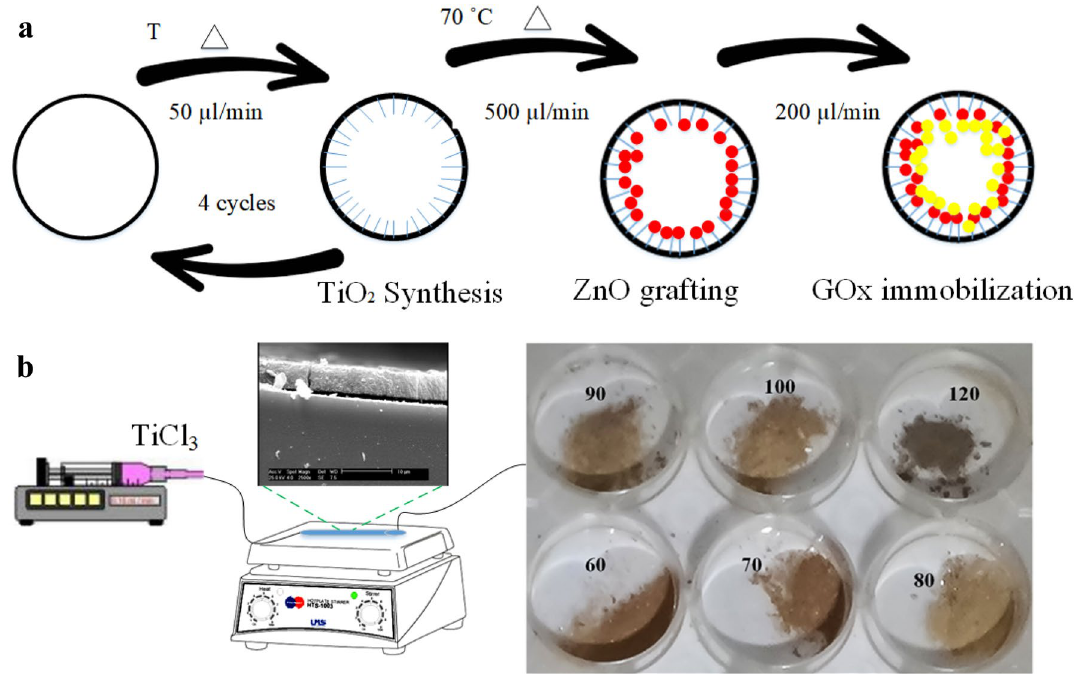
Figure 1. ( a ) GOx/ZnO/TiO 2 bio-photo-catalyst synthesis steps from the cross-sectional view, ( b ) schematic of the simple facilities used and the